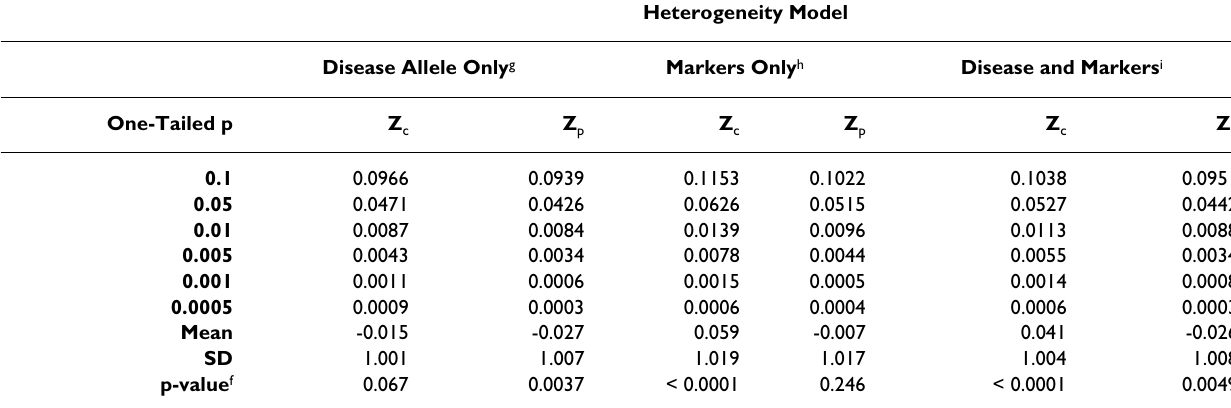
Table 3: Simulation results under varied conditions of